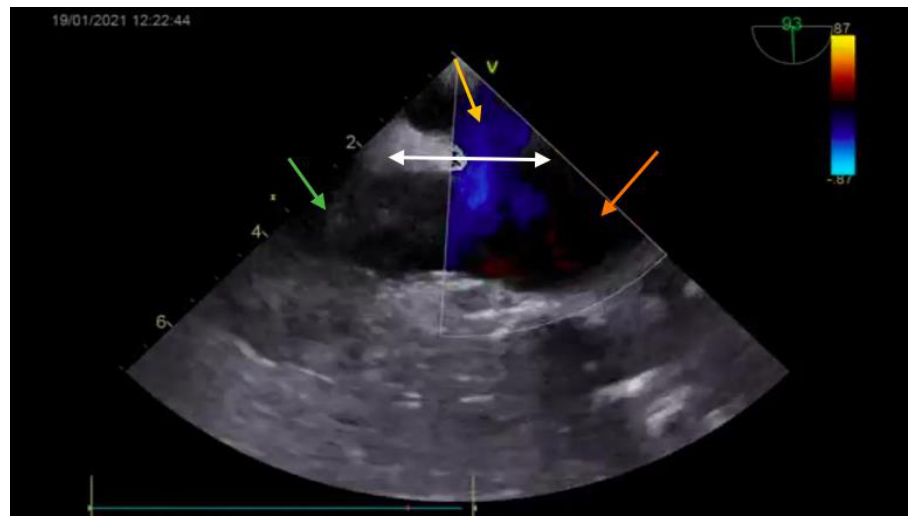
Figure 1. Preoperative echocardiography (bicaval view — Doppler; SVC — green arrow; right atrium — orange arrow; interatrial septum — white arrow) showing the ASD (yellow arrow).